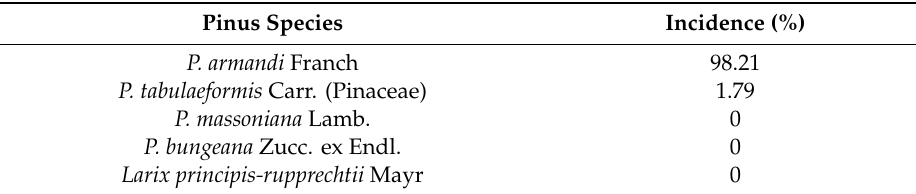
Table 6. Incidence (%) of D. armandi in